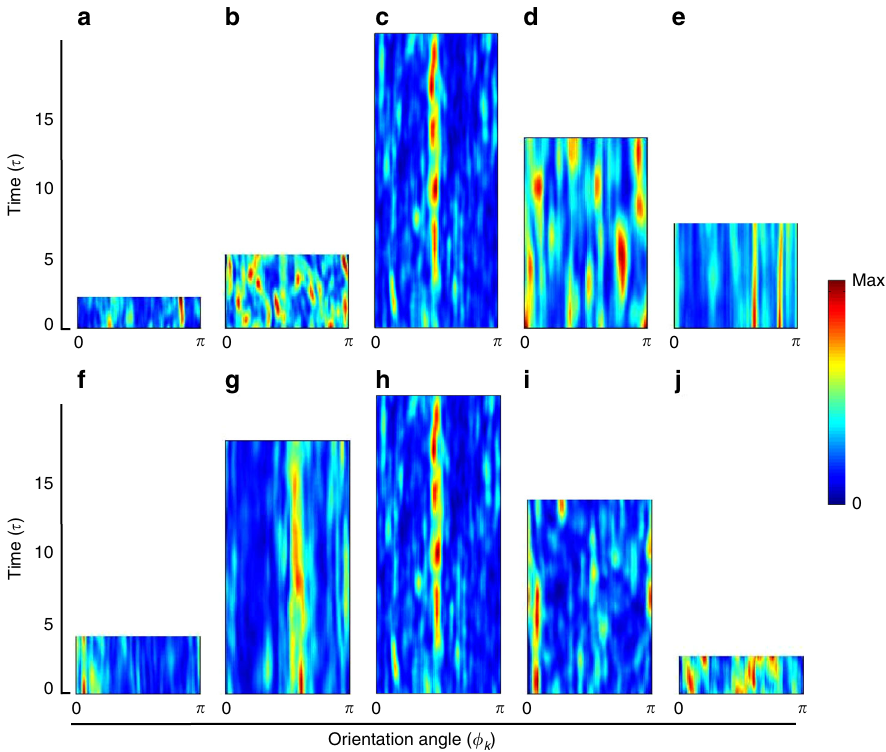
Fig. 5 Slow time evolution of superstructures. Color density plot of the radially averaged temperature power spectrum E Θ ( ϕ k ; τ , t 0 ) as a function of time t 0 (in units of τ ) and orientation angle ϕ k . We plot the angle in wavenumber space, ϕ k = arctan( k y / k x ) between 0 and π . All panels are rescaled with their corresponding characteristic time τ . The top row shows data for Ra = 10 5 . a Pr = 0.005, b Pr = 0.021, c Pr = 0.7, d Pr = 7, and e Pr = 70. The bottom row shows data for Pr = 0.7. f Ra = 5 × 10 3 , g Ra = 10 4 , h Ra = 10 5 , i Ra = 10 6 , and j Ra = 10